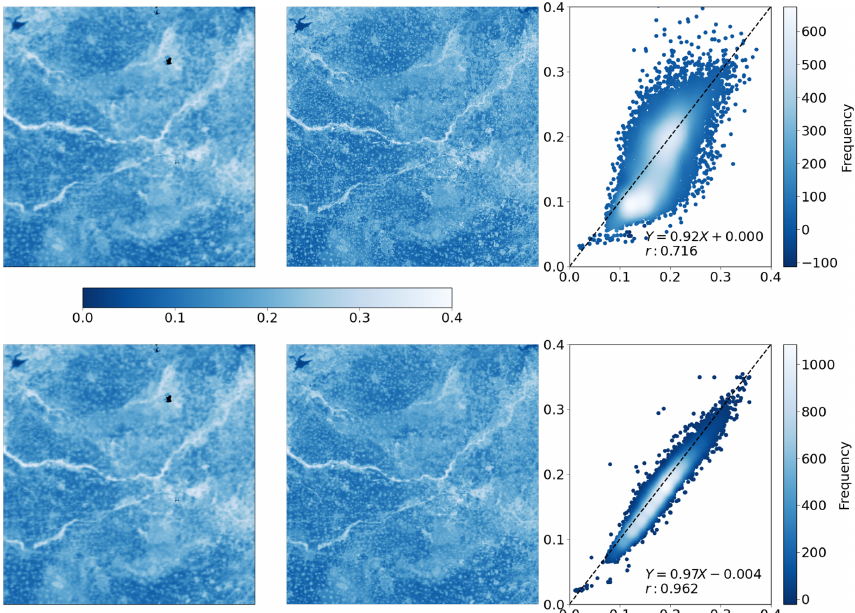
Figure E2. Comparison between MCD43-simulated surface reflectance after spectral mapping r c ((cid:51)(m)) with S2 TOA reflectance ˆ y and S2 TOA reflectance after spatial mapping ˆ y(G c ) on 13 April 2016 S2 50SLH tile. Top row is the r c ((cid:51)(m)) and S2 TOA reflectance ˆ y , with the scatter plot between the corresponding pixels (pixel’s centre geolocation) on the right side. Bottom row is the r c ((cid:51)(m)) , with ˆ y(G c ) and their scatter plot.